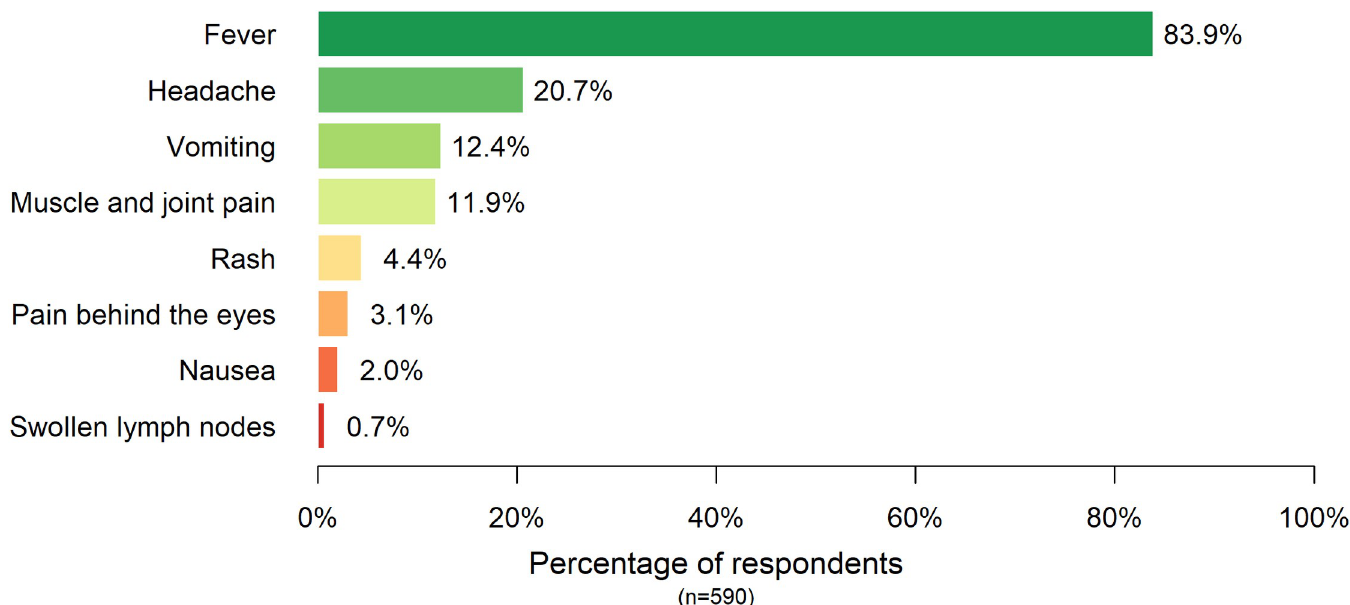
Fig 2. Symptoms of dengue fever recognized by respondents in September 2018. Note: Respondents can choose more than 1 answer.